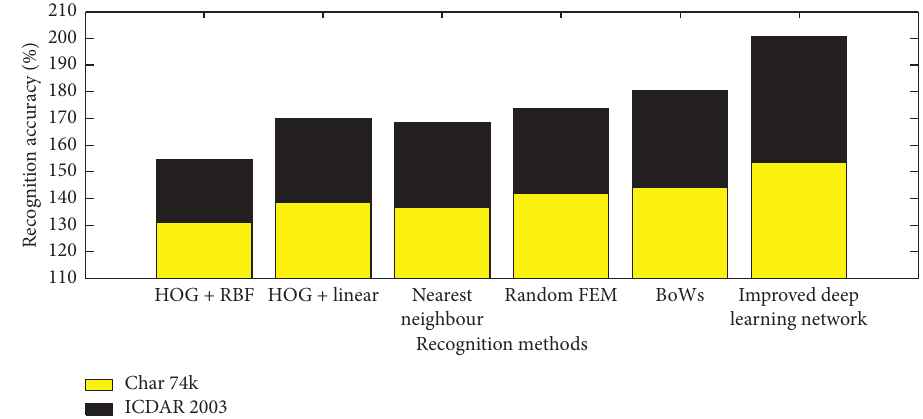
Figure 8: Experimental results of character recognition based on the improved deep learning network model.